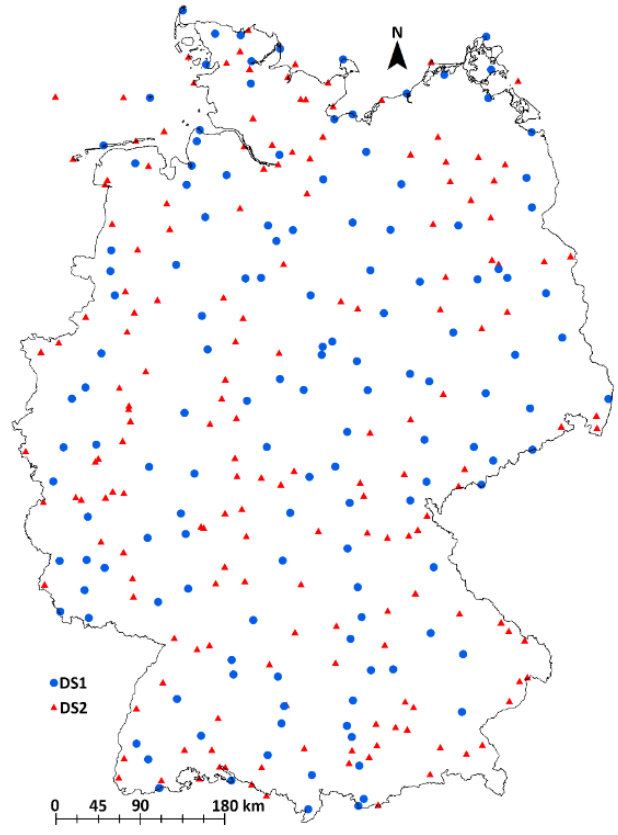
Figure 2. Gust speed ( GS ) measurement stations subdivided into a parameterization dataset (DS1) and test dataset (DS2).